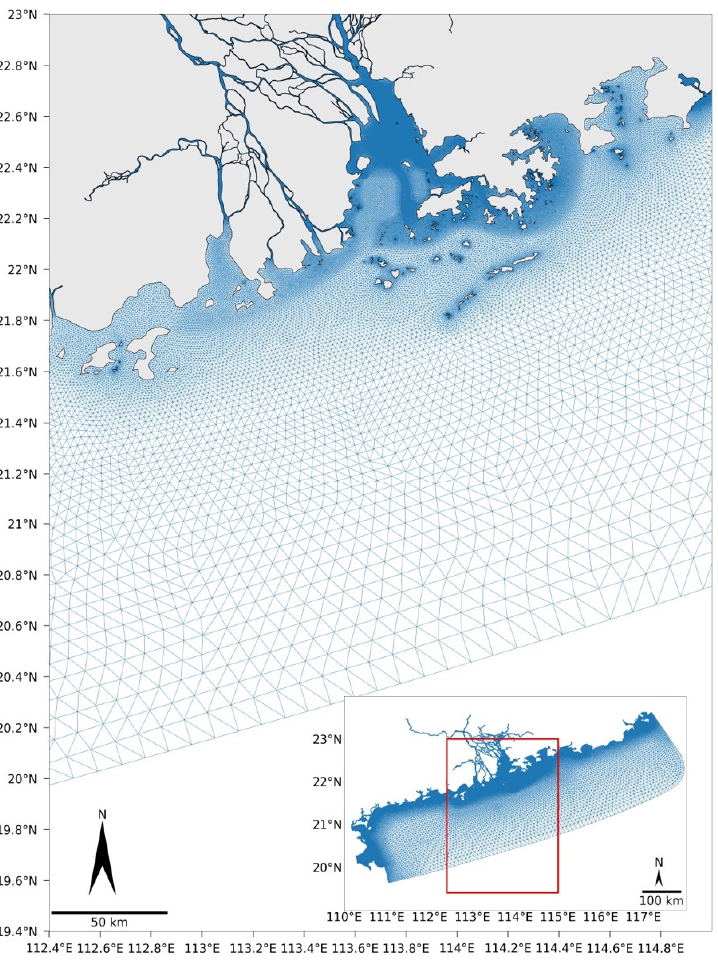
Figure 2. The entire model domain (small box), along with a zoomed-in view of the subdomain (red box) in the PRE.